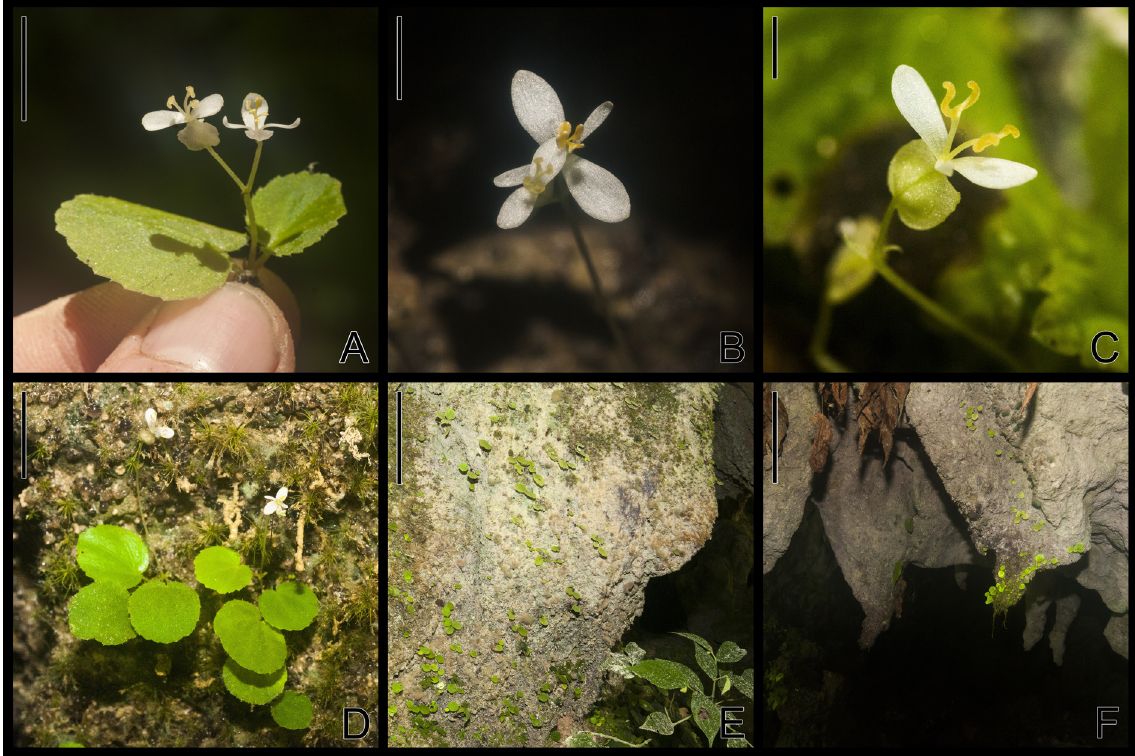
Fig 3. Begonia elachista Moonlight & Tebbitt sp. nov. A . Whole plant. B . Male and female flower, front view. C . Female flower, side view. D . Habit and associated vegetation. E–F . Habitat and wild population. Scale bars: A = 1 cm; B = 5 mm; C = 2 mm; D = 2 cm; E–F = 10 cm. Photographed by Peter Moonlight. All from P. Moonlight & A. Daza 318